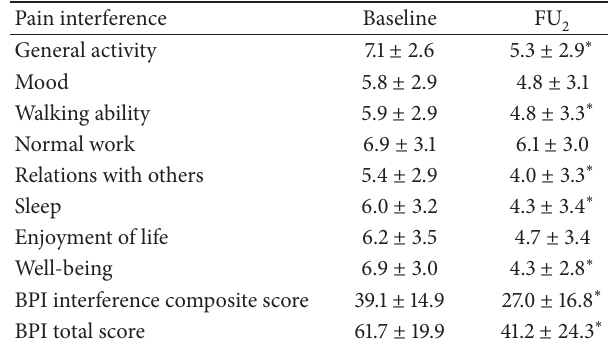
Table 4: Pain interference.